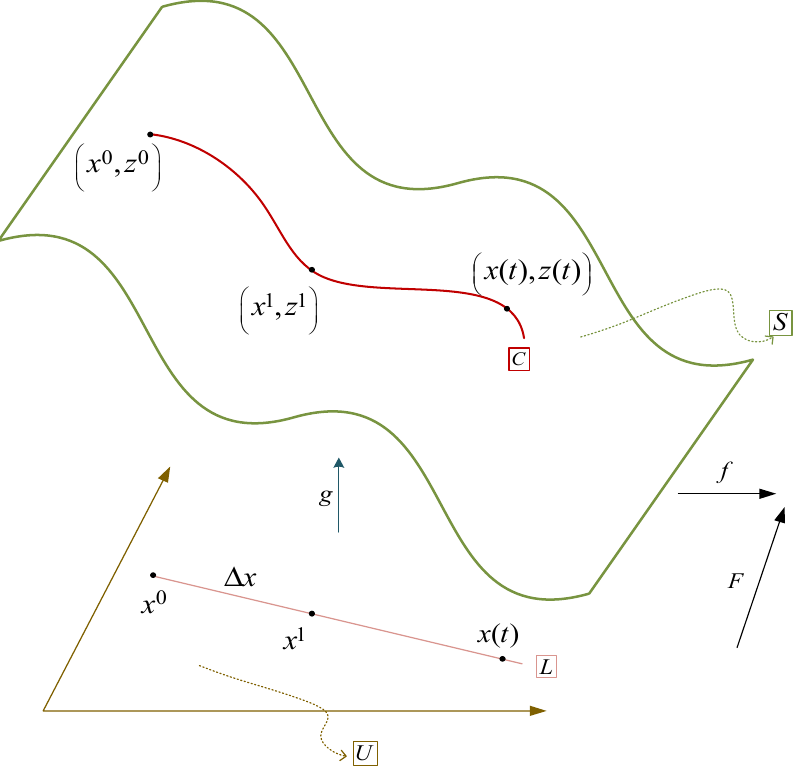
Figure 1. The relationship between induced line search and movement along the original feasible set.